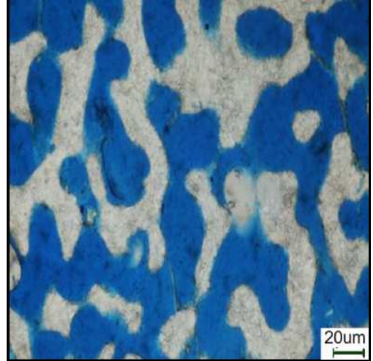
Figure 2. Cast thin section of coral